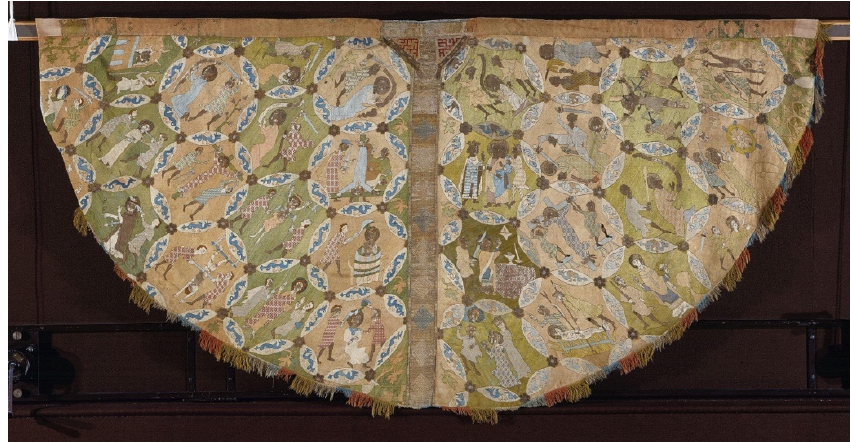
Figure 19. Hildesheim Cope, 1310–1320, from Hildesheim Cathedral. London, Victoria and Albert Museum, England. © Victoria and Albert Museum, London.